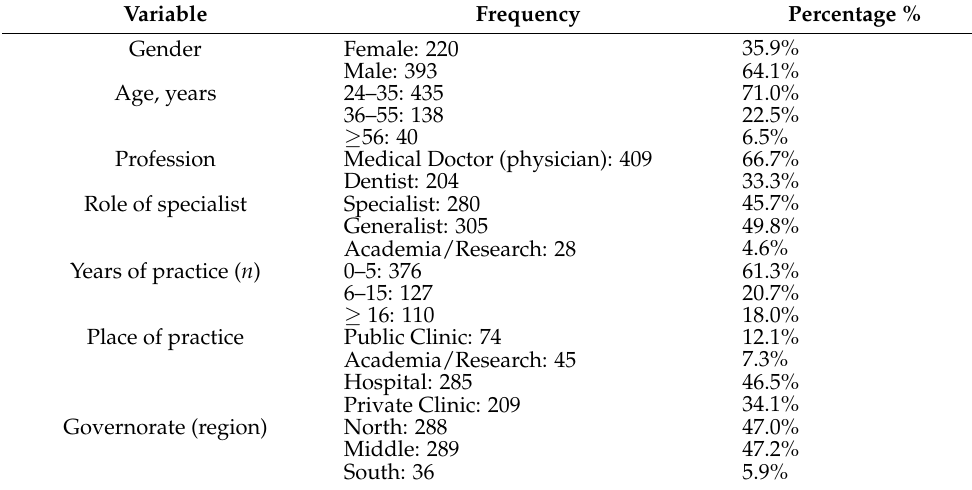
Table 1. Respondents’ sociodemographic characteristics ( n =